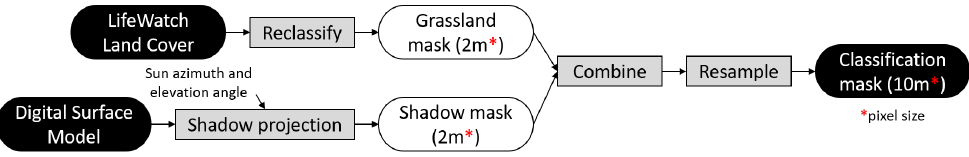
Figure 3. Classification mask flowchart. The mask was built using the two grassland classes of the LifeWatch land-cover product and shadow projections based on a digital surface model (DSM). The mask was resampled to 10m to match the pixel size of Sentinel-2.